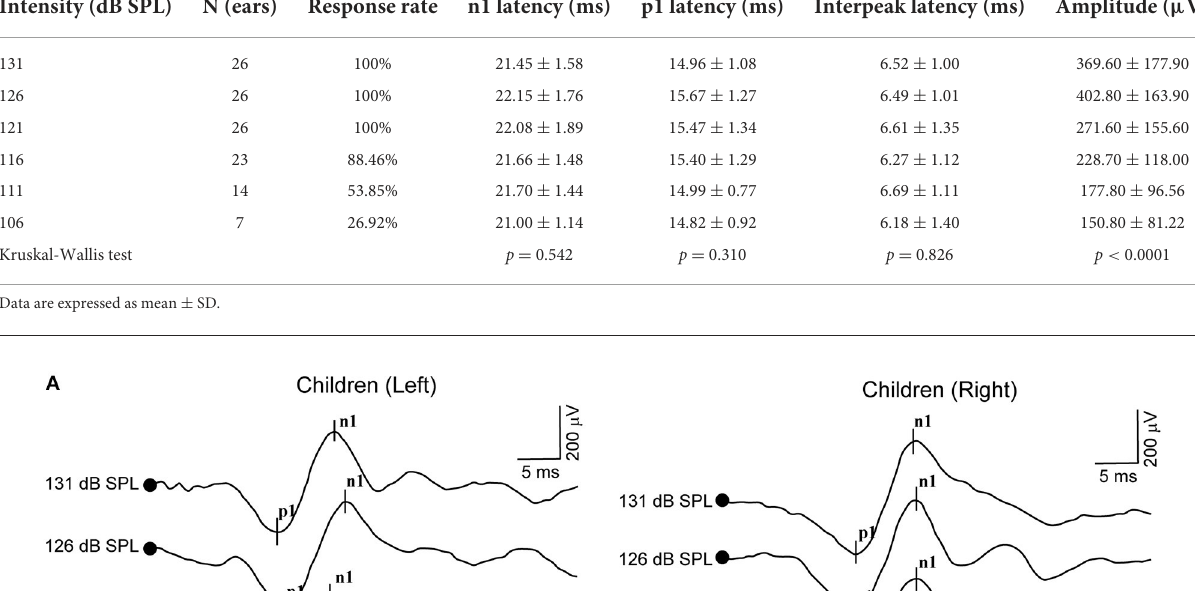
TABLE 2 The ACS-cVEMP with decreasing acoustic stimulation intensity in children.